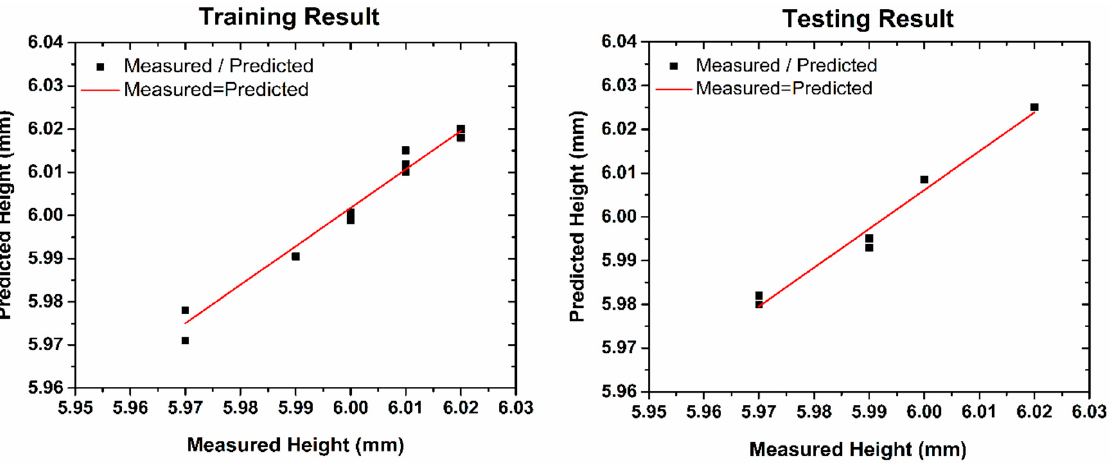
Figure 4. Comparison between the measured and the predicted heights in the training/testing phases.